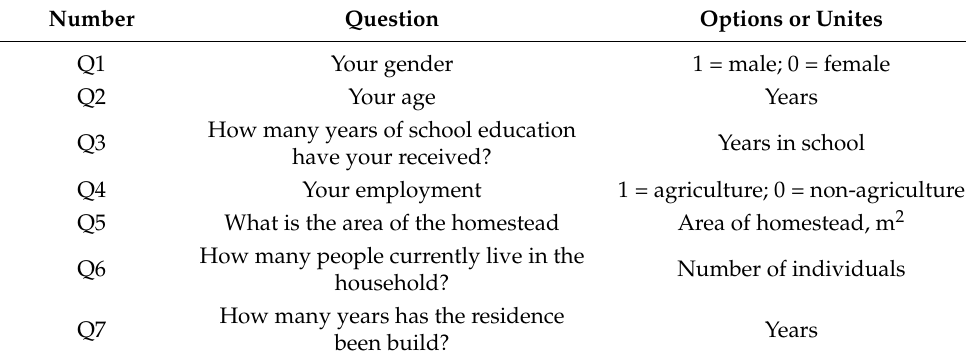
Table 1. Questionnaire on rural homestead.